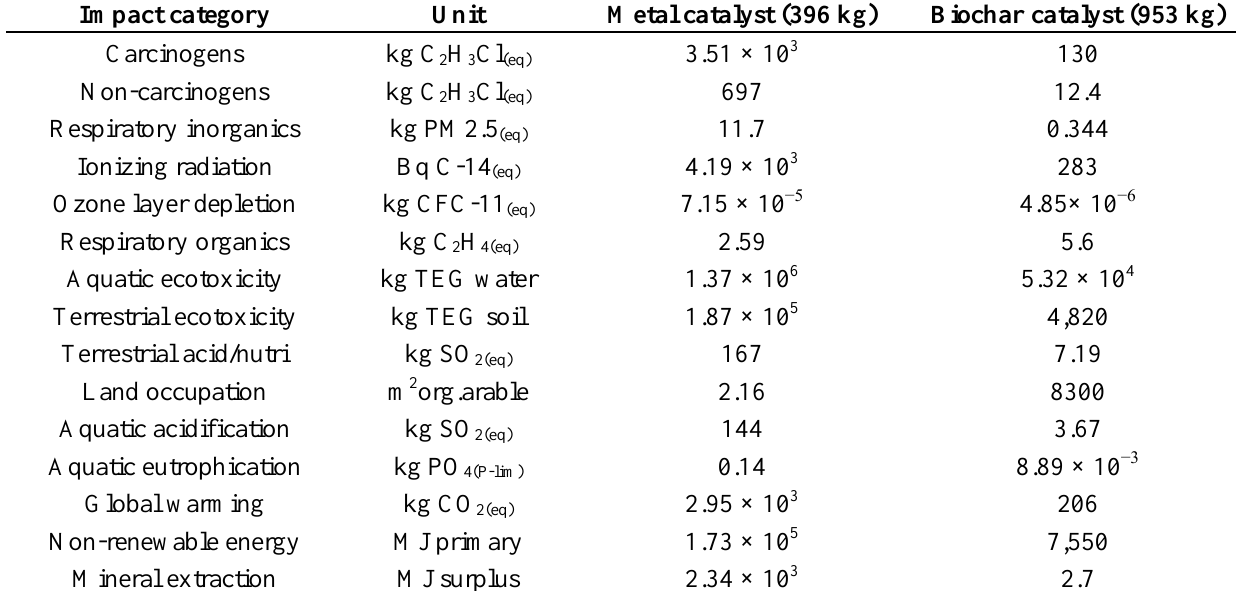
Table 5. Characterized LCA comparison results (total value in each impact